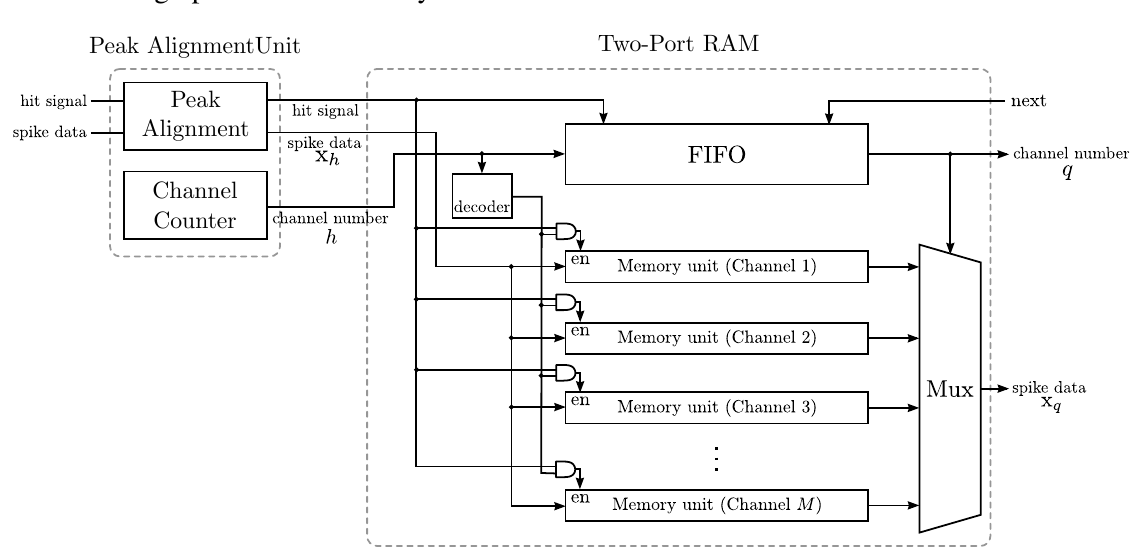
Figure 4. The architecture of the spike buffer for spike alignment. The architecture contains a peak alignment unit and a two-port RAM. The spikes aligned by the peak alignment unit are stored in the two-port RAM. The spike buffer is able to align and store detected spikes up to M